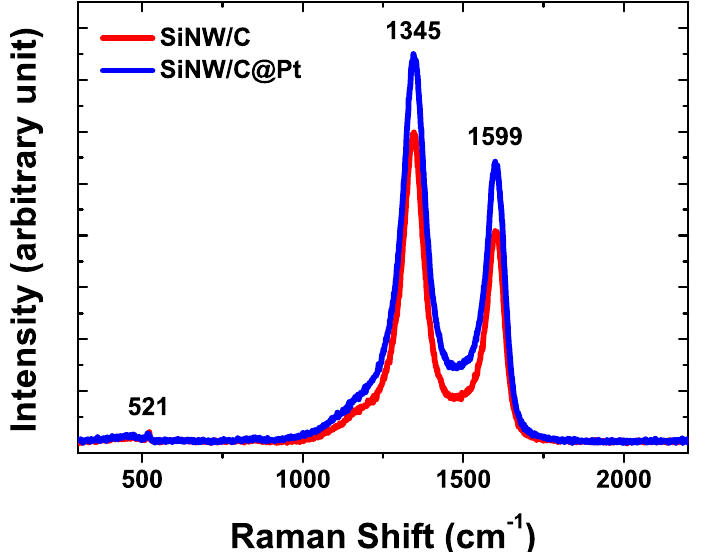
Figure 3. Raman spectra of SiNW/C and